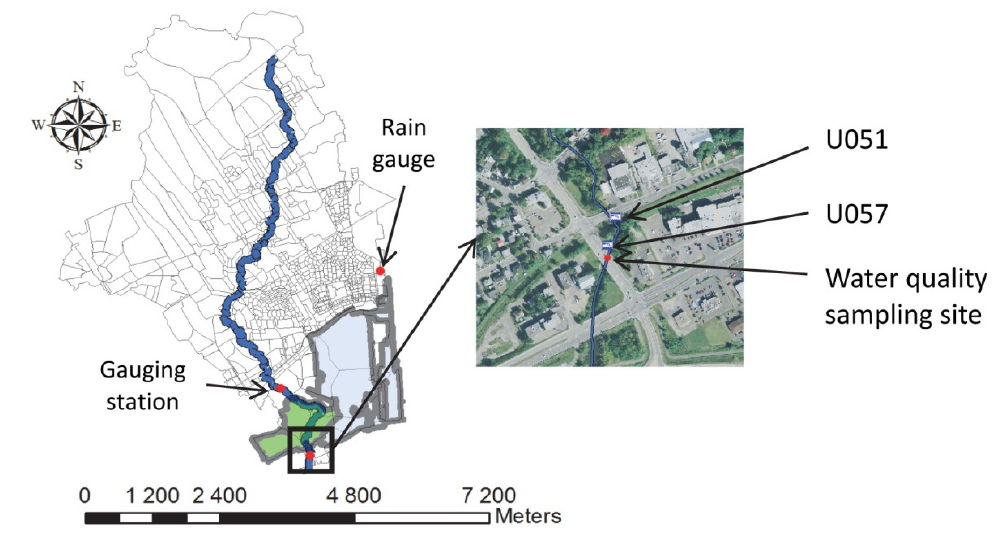
Figure 1. Land use in the Beauport River watershed.